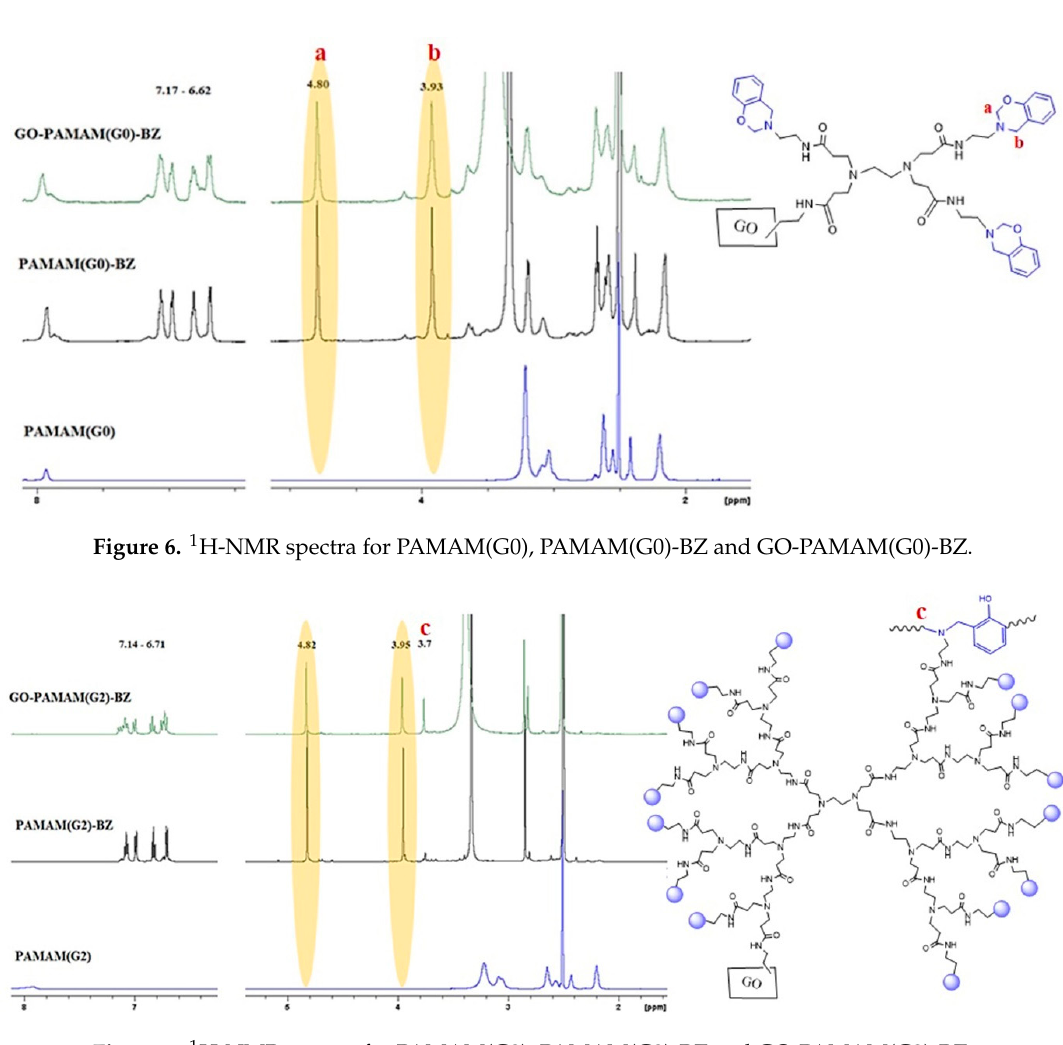
Figure 7. 1 H-NMR spectra for PAMAM(G2), PAMAM(G2)-BZ and GO-PAMAM(G2)-BZ .